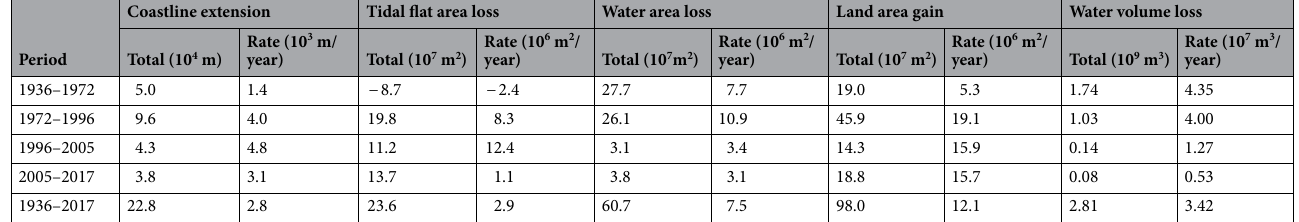
Table 2. Changes in coastline, tidal flat area, water area, land area and water volume in the estuary for different time periods.